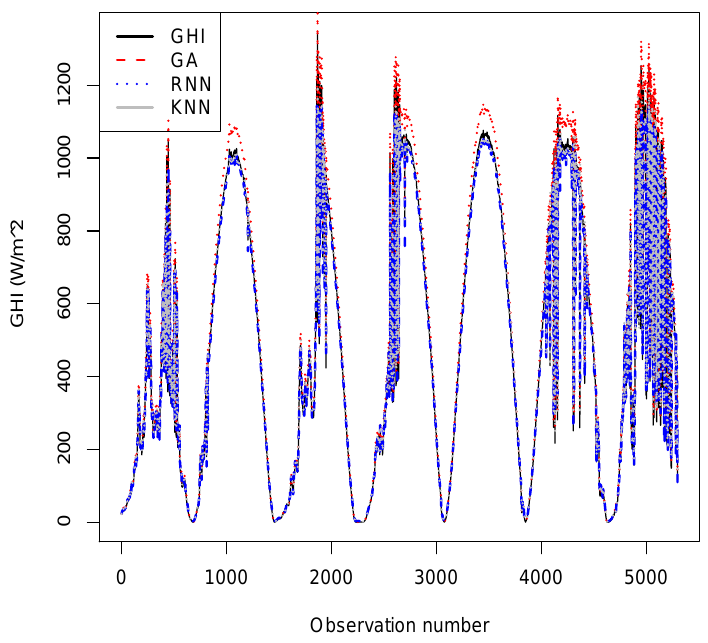
Figure 4. Plot of GHI superimposed with forecasts from RNN, GA, and KNN models.